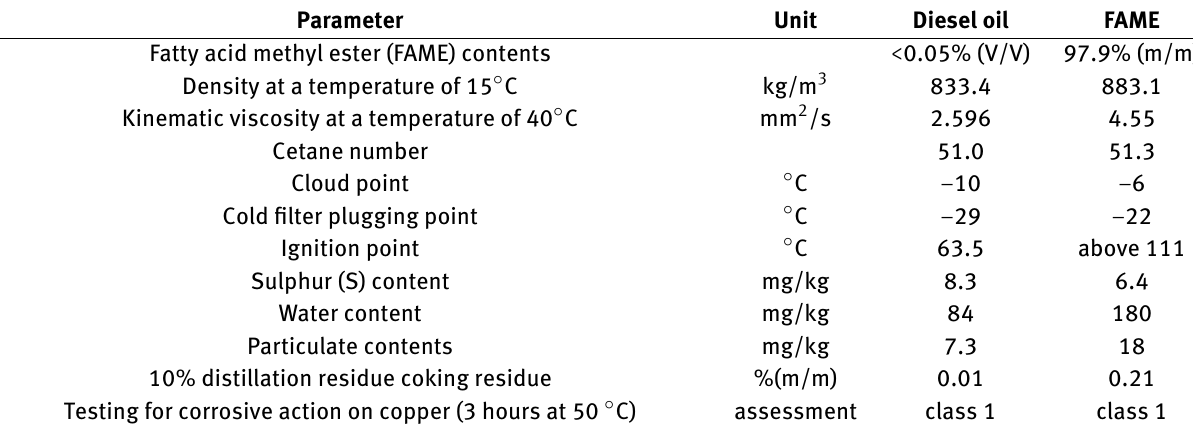
Table 2: Basic physicochemical properties of commercial diesel oil and rape oil fatty acid methyl esters as stated in the Quality Certificates of these fuels [42,